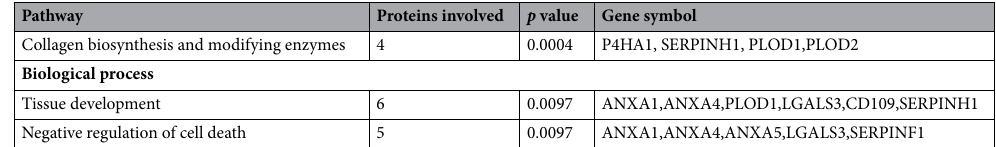
Table 2. Pathway analysis. Table displays the results of the STRING and DAVID pathway analysis version 6.8. The first (left) column shows the identified pathways that are involved in ECM assembly; the second column shows the number of proteins of interest involved in that pathway, the third lists the p values of pathways and the fourth displays the gene symbols of the proteins involved. In total, 10 proteins were identified in one pathway and two biological